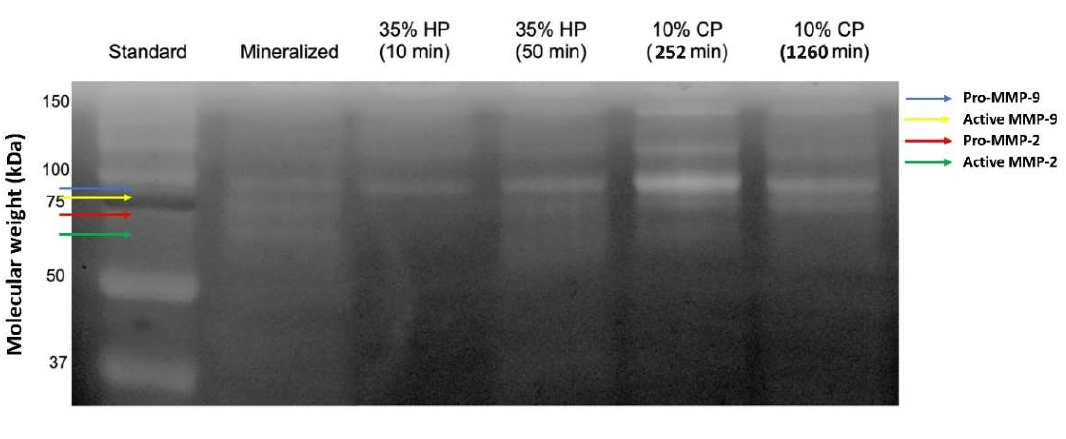
Figure 3. Zymography of protein extracts obtained from dentin powder. Lane 1: standards (Std) in kDa; Lane 2: mineralized untreated dentine powder; Lane 3: dentin powder treated with hydrogen peroxide (HP) 35% for 10 min; Lane 4: dentin powder treated with HP 35% for 50 min; Lane 5: dentin powder treated with carbamide peroxide (CP) at 10% for 252 min; Lane 6: dentin powder treated with CP 10% for 1260 min. Different colored arrows mark the molecular weight of different MMPs.